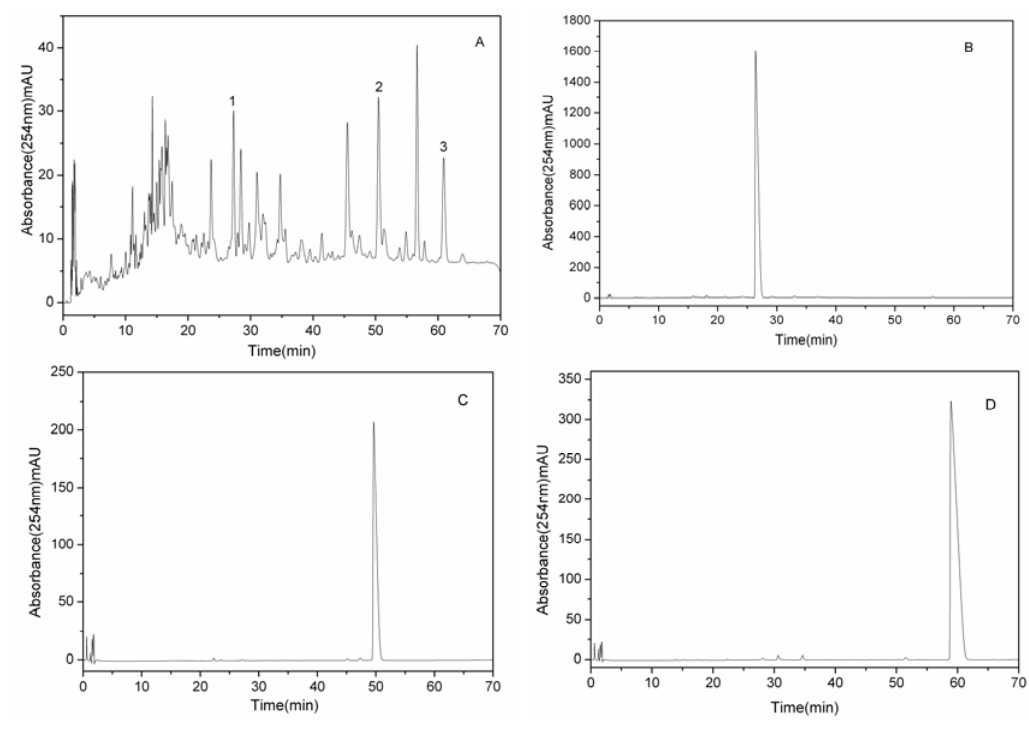
Figure 3. HPLC chromatograms of n-butanol fraction of the Eupatorium lindleyanum DC. ethanol extract and HSCCC peak fractions. ( A ) Crude sample; ( B ) Peak 1 in Figure 2; ( C ) Peak 2 in Figure 2; ( D ) Peak 3 in Figure